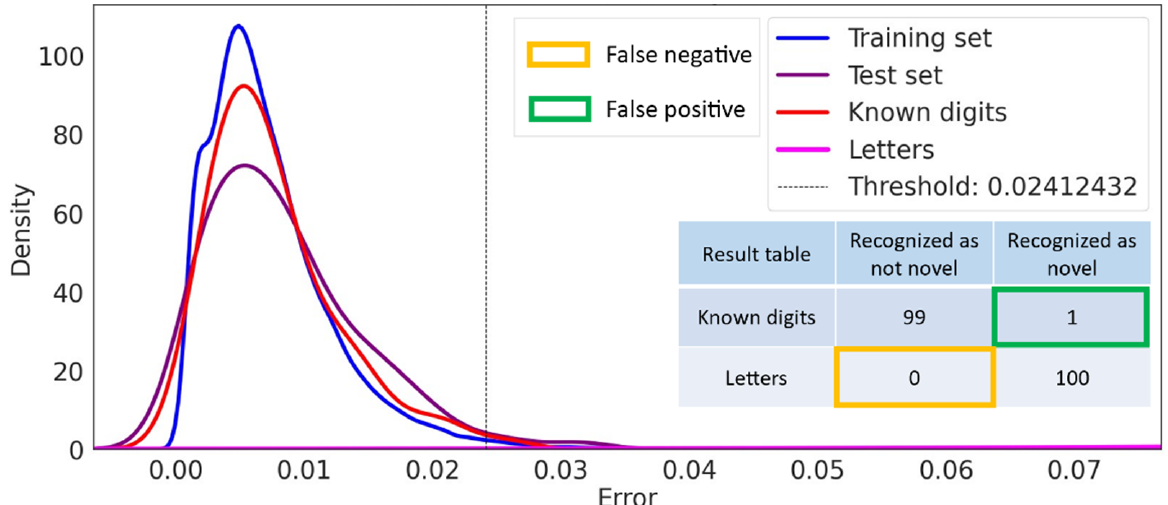
Figure 4. Reproduced results of the “naive” novelty detection approach of [9].